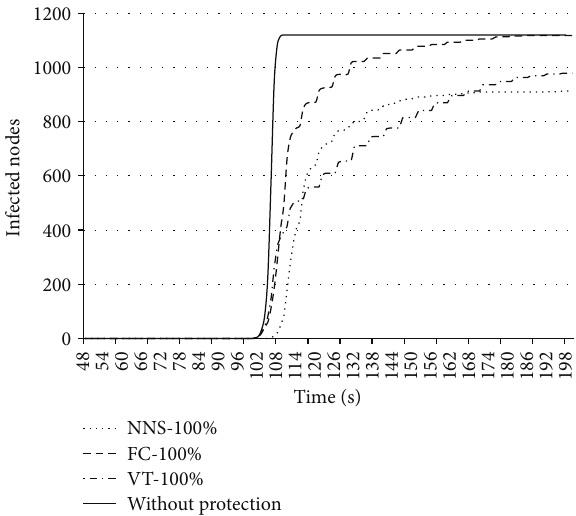
Figure 3: Number of the infected hosts depending on protection mechanism used (FC-100%, VT-100%, NSS-100%, or without pro-